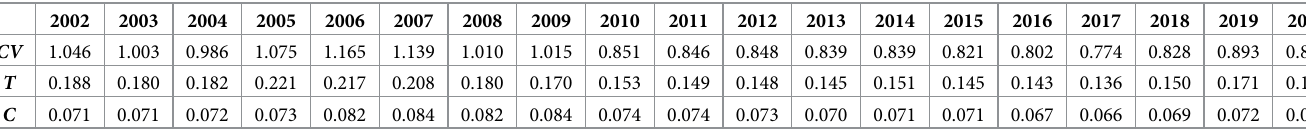
Table 1. Economic development difference indicators of the Russian Federation during 2002–2020.